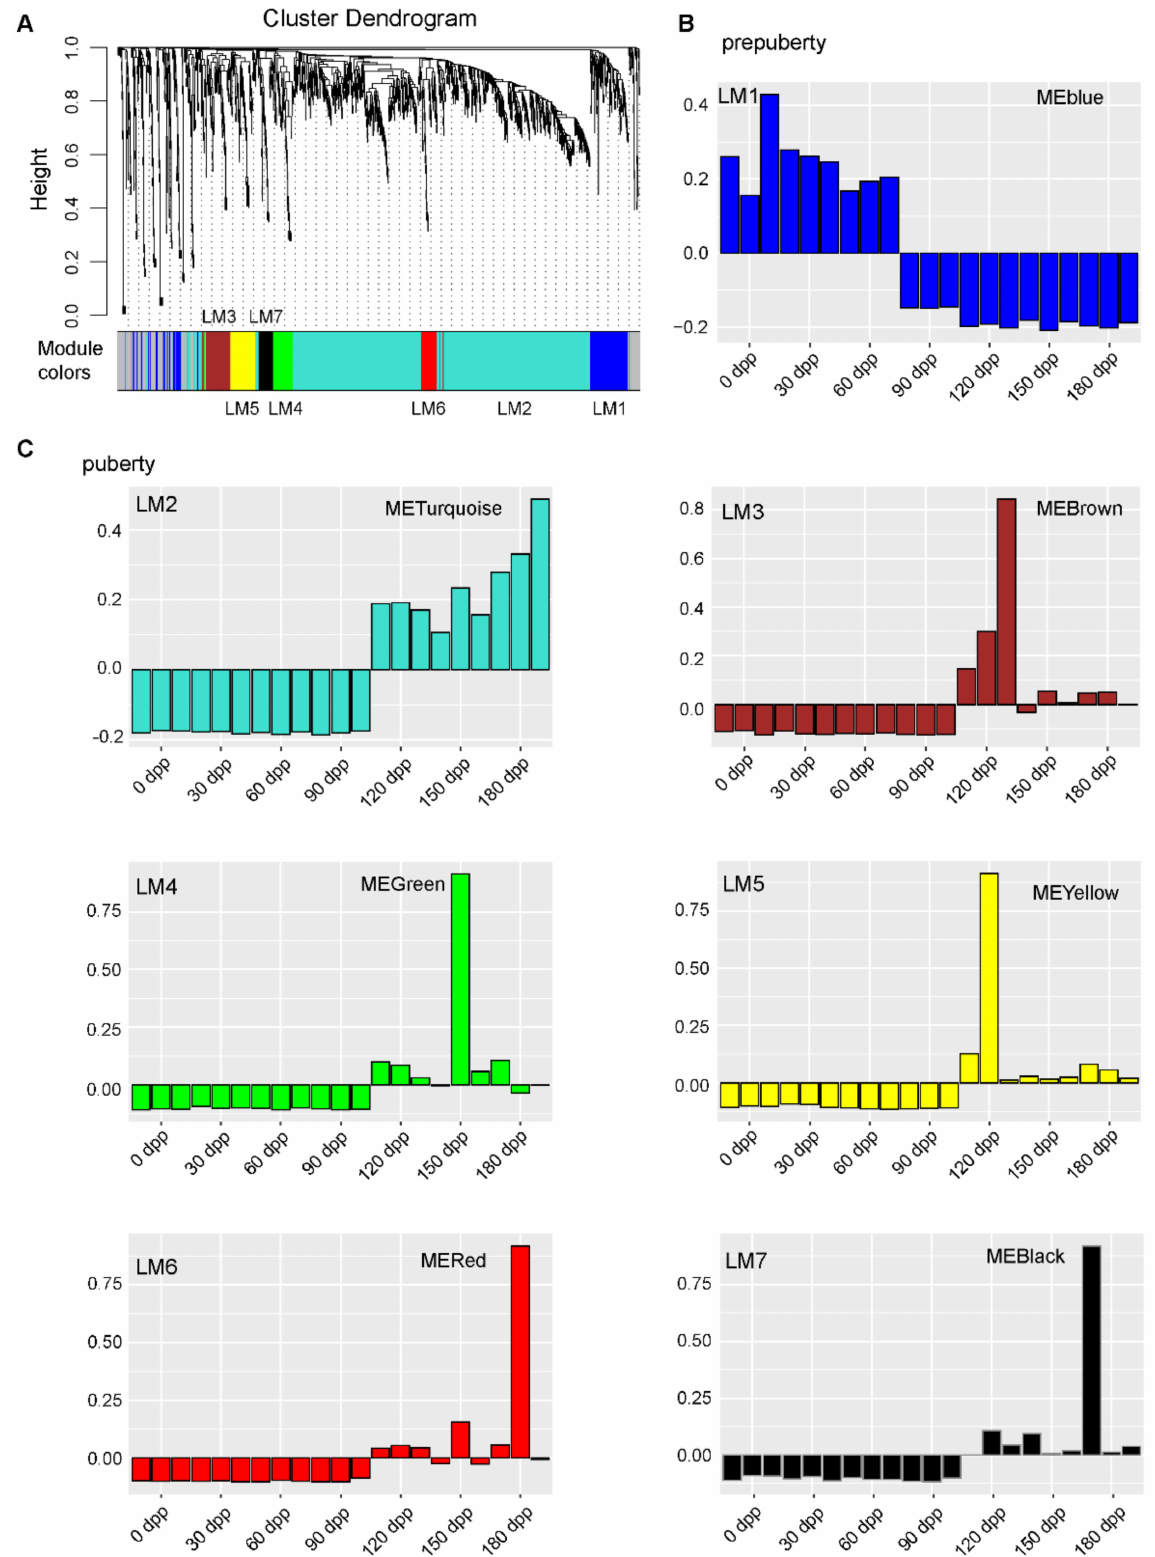
Figure 3. LincRNAs are clustered into temporal-specific modules by the weighted gene co-expression network analysis. ( A ) Hierarchical cluster dendrogram of all lincRNAs modules. Modules corresponding to branches are labeled with colors indicated by the color bands underneath the tree. ( B , C ) Eigengene bar plot of lincRNA modules. Samples were sorted by days postnatal in the order of 0, 30, 60, 90, 120, 150, and 180 DP. LM represents lincRNA